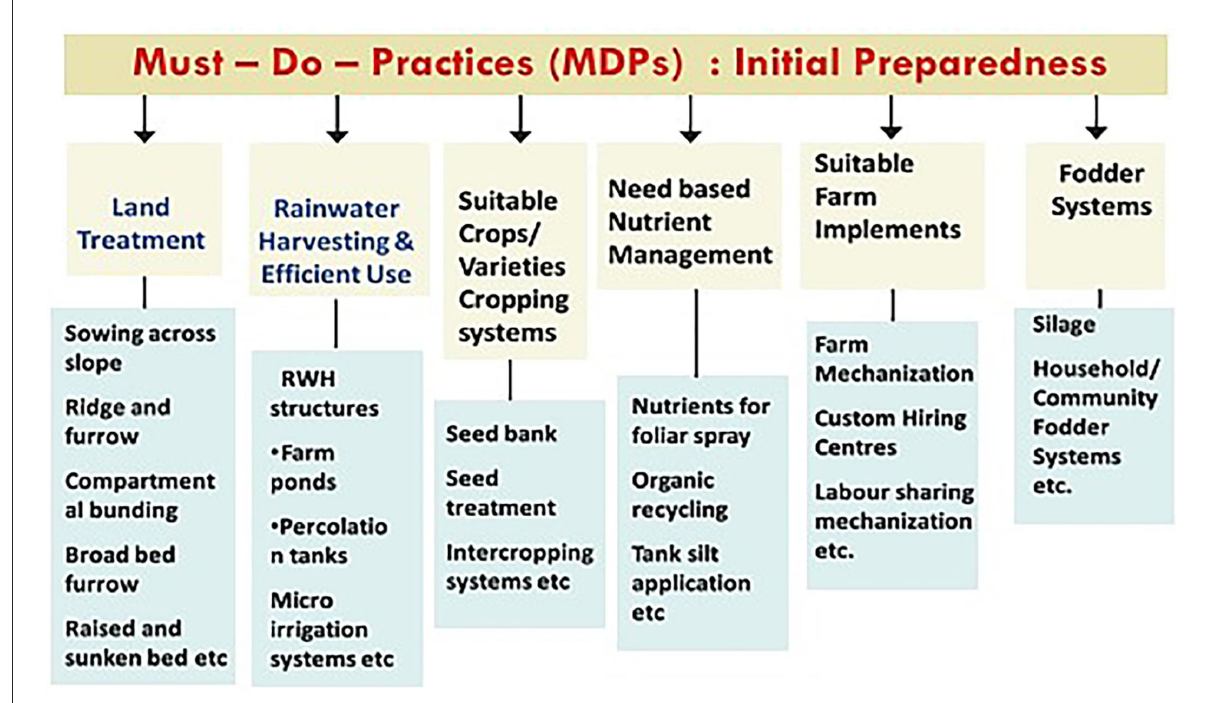
FIGURE5 Must-do practices to prepare the soil and cropping systems for climate-induced water stresses. Adapted from Singh et al.